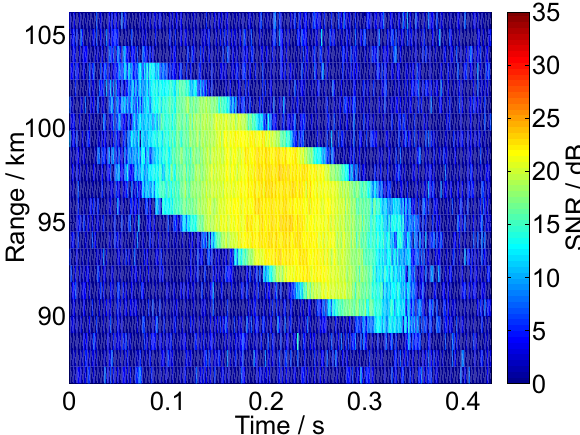
Fig. 3. Measured phase differences between receiver Rx8 and the exterior receiver Rx2 and Rx4.